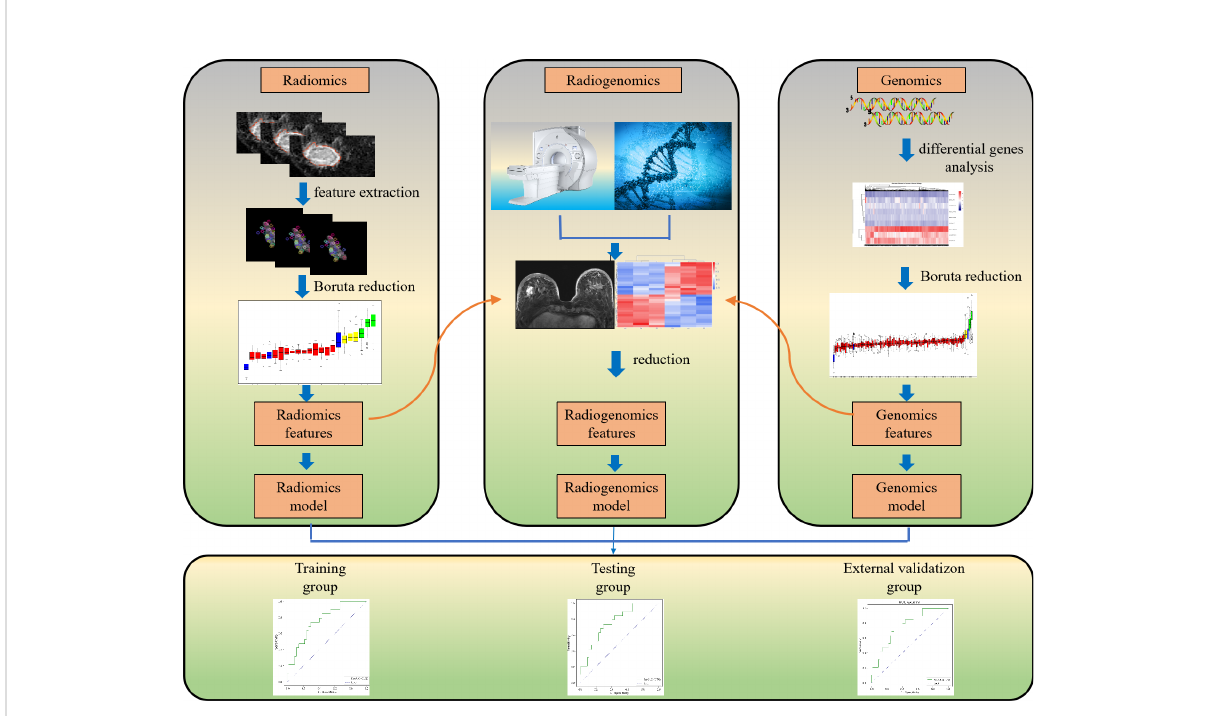
FIGURE 1 Framework